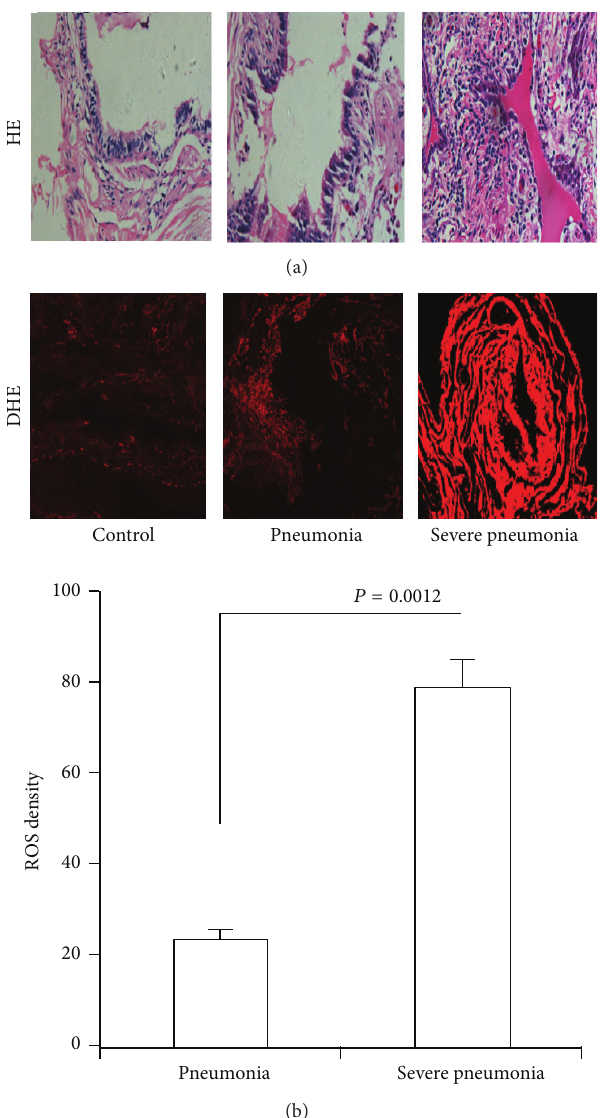
Figure 1: Oxidative stress in severe CAP . (a) HE staining of lung tissue from no severe CAP and severe CAP patients. (b) ROS were detected by confocal microscope using DHE probe. ROS level was represented by fluorescence intensity ( × 200).